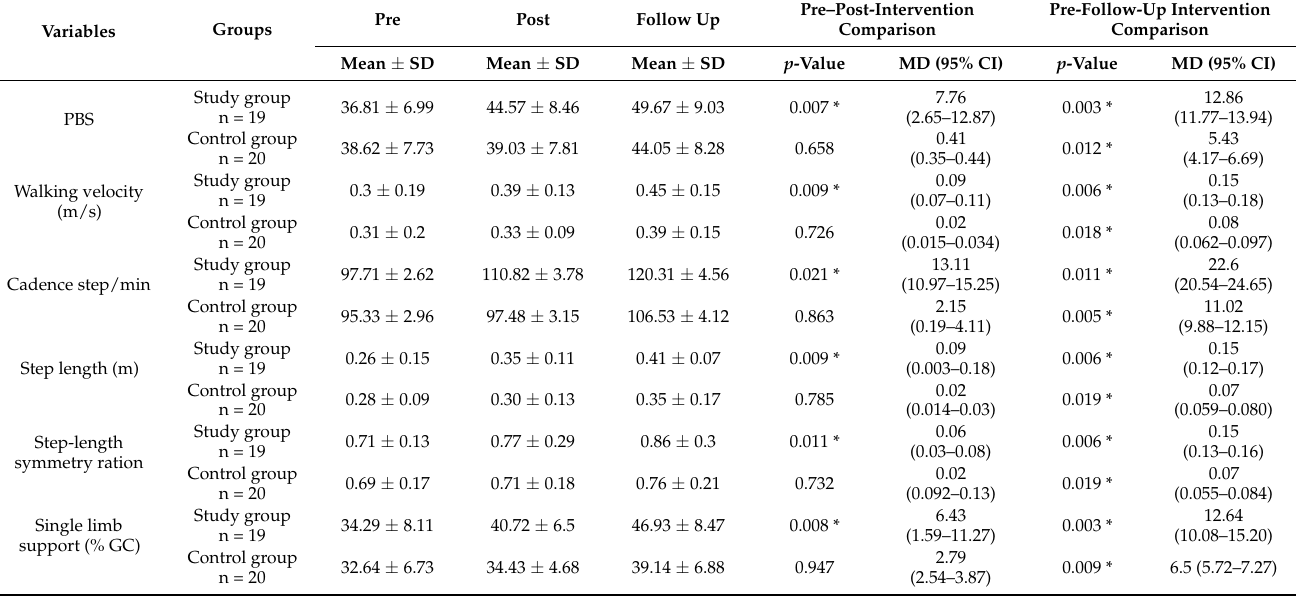
Table 2. This is a table of pre-intervention, post-intervention and follow up of all outcome measures of the study and control